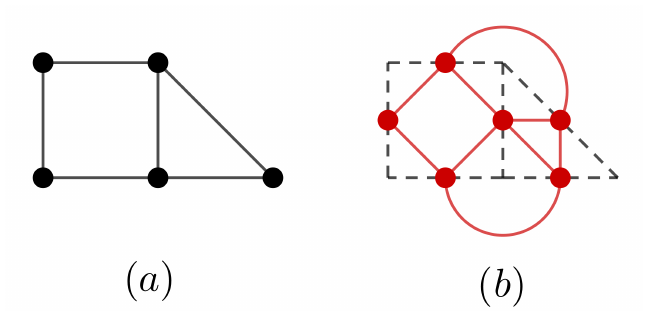
Figure 1. In ( a ) a graph G, in ( b ) graph L ( G ) .